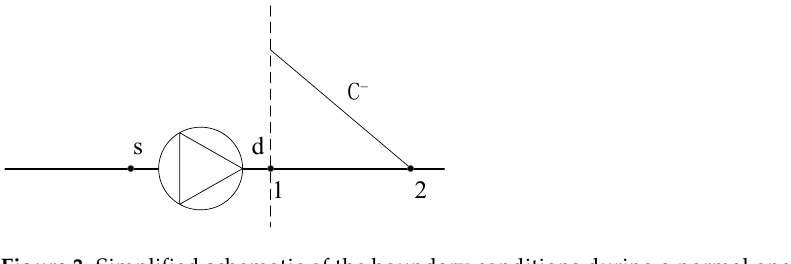
Figure 3. Simplified schematic of the boundary conditions during a normal operation of the pump- ing station.